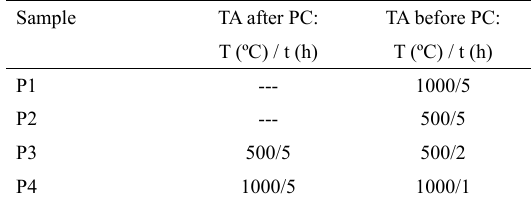
Table 1. Thermal annealing of the samples, before and after pellet compression (PC), as function of Temperature (T) and time (t).